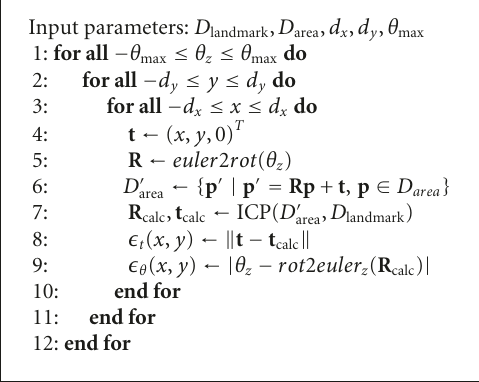
Algorithm 1: Landmark grid test